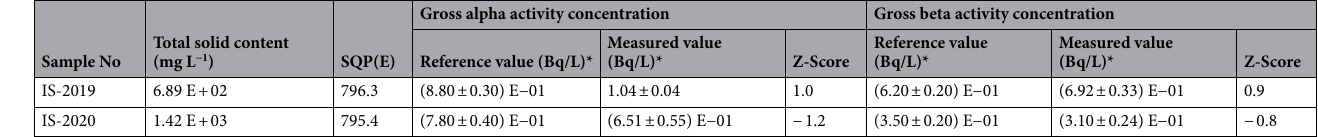
Table 7. The results of gross alpha and gross beta activity concentrations for water samples from proficiency tests. *The expanded uncertainty corresponds to k = 1.